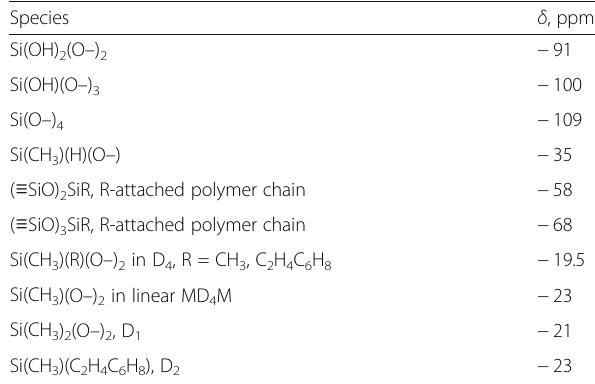
Table 2 29 Si Chemical shifts ( δ ) of grafted neat and depolymerizied organosiloxane species at SiO 2 surface